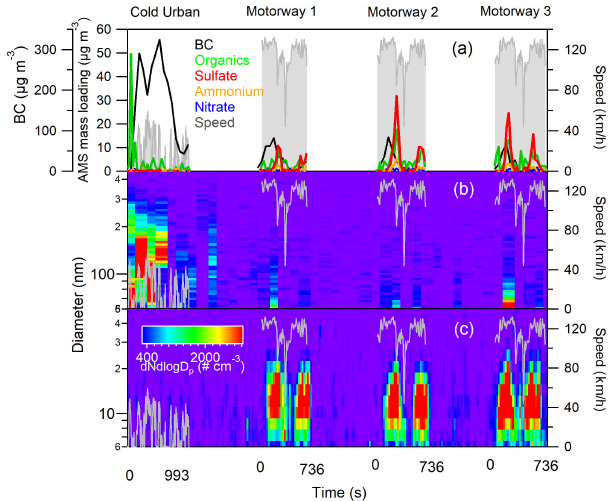
Figure 2. PM emissions from the D1 vehicle, during a cold urban cycle and three successive motorway cycles: (a) AMS major chem- ical species and BC (MAAP), (b) size distribution of fine particles (SMPS), and (c) size distribution of ultrafine particles (SMPS +